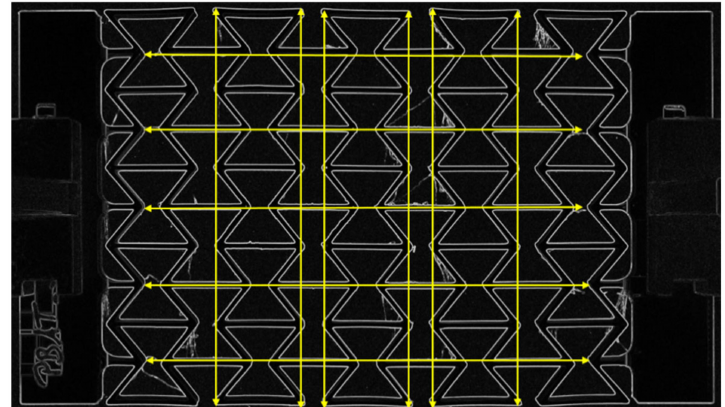
Figure 11. Exemplary representation of the measurement of an auxetic structure.